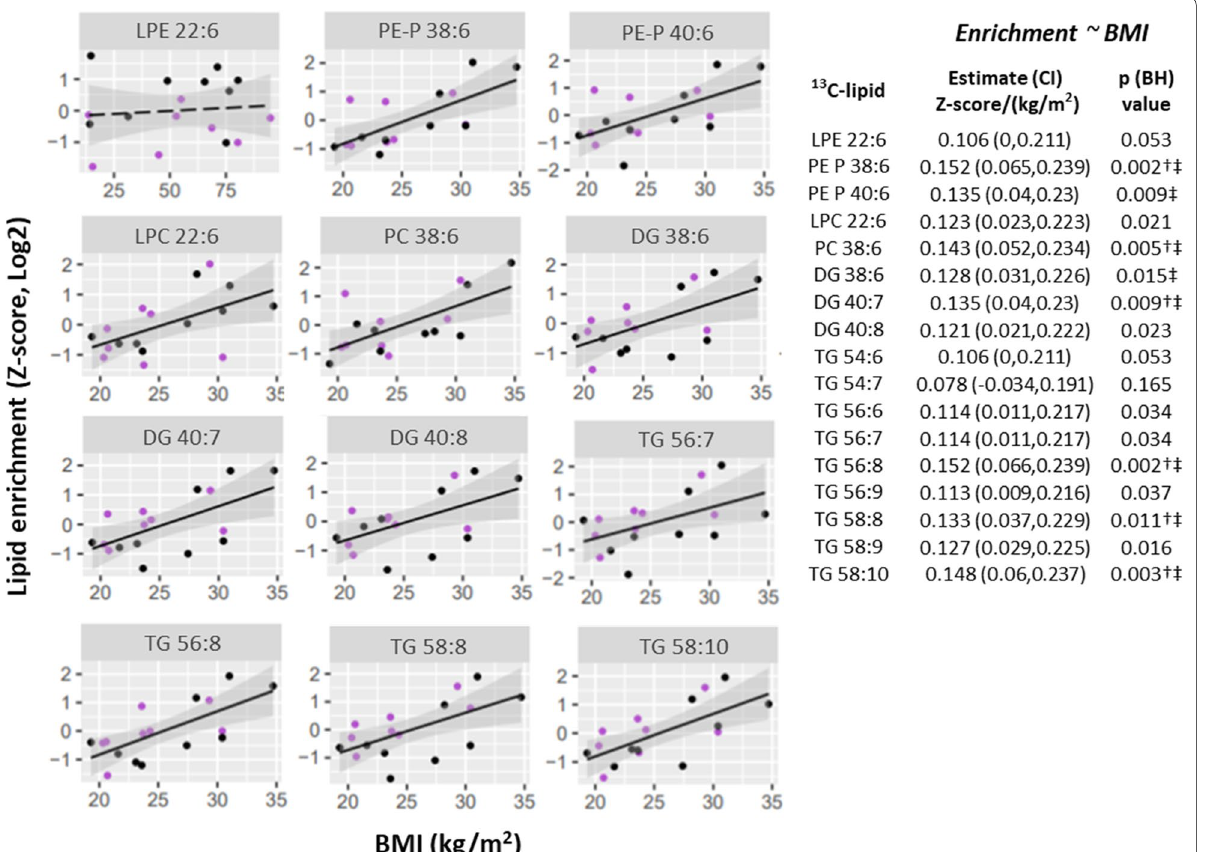
17 placenta) in culture at a =